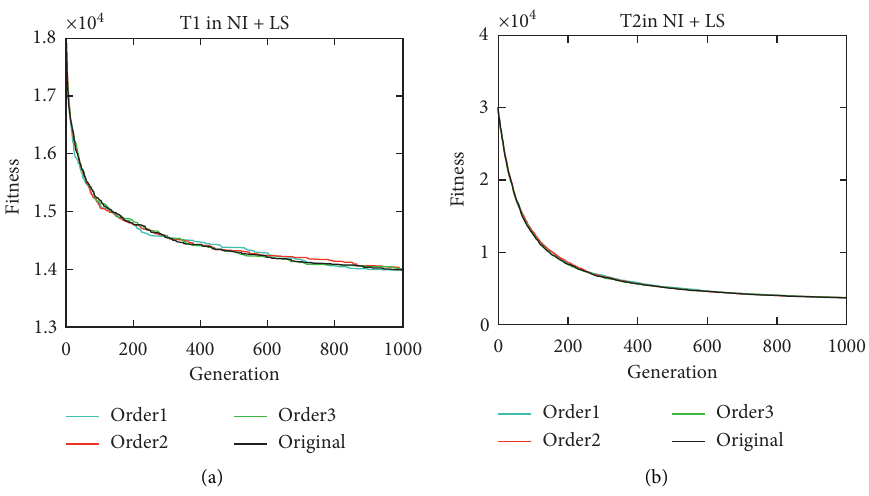
Figure 12: Convergence of MFEA for problem 9 (NI+LS).